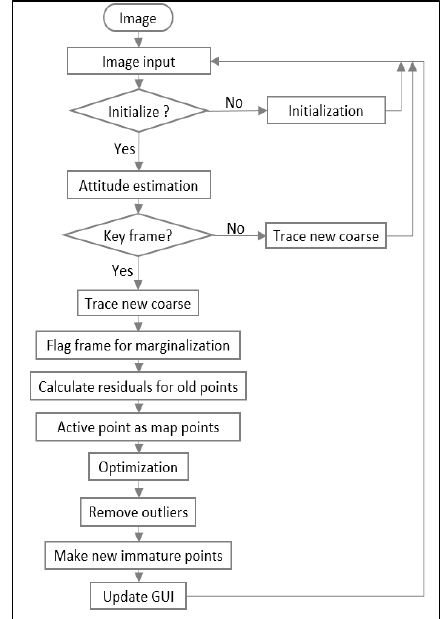
Figure 3. DSO system flow chart (J. Engel et al.,